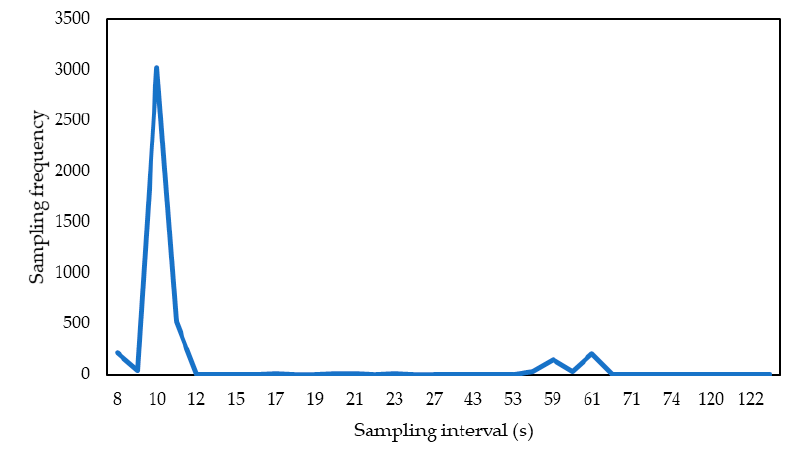
Figure 4. The sampling frequency distribution of different sampling intervals.